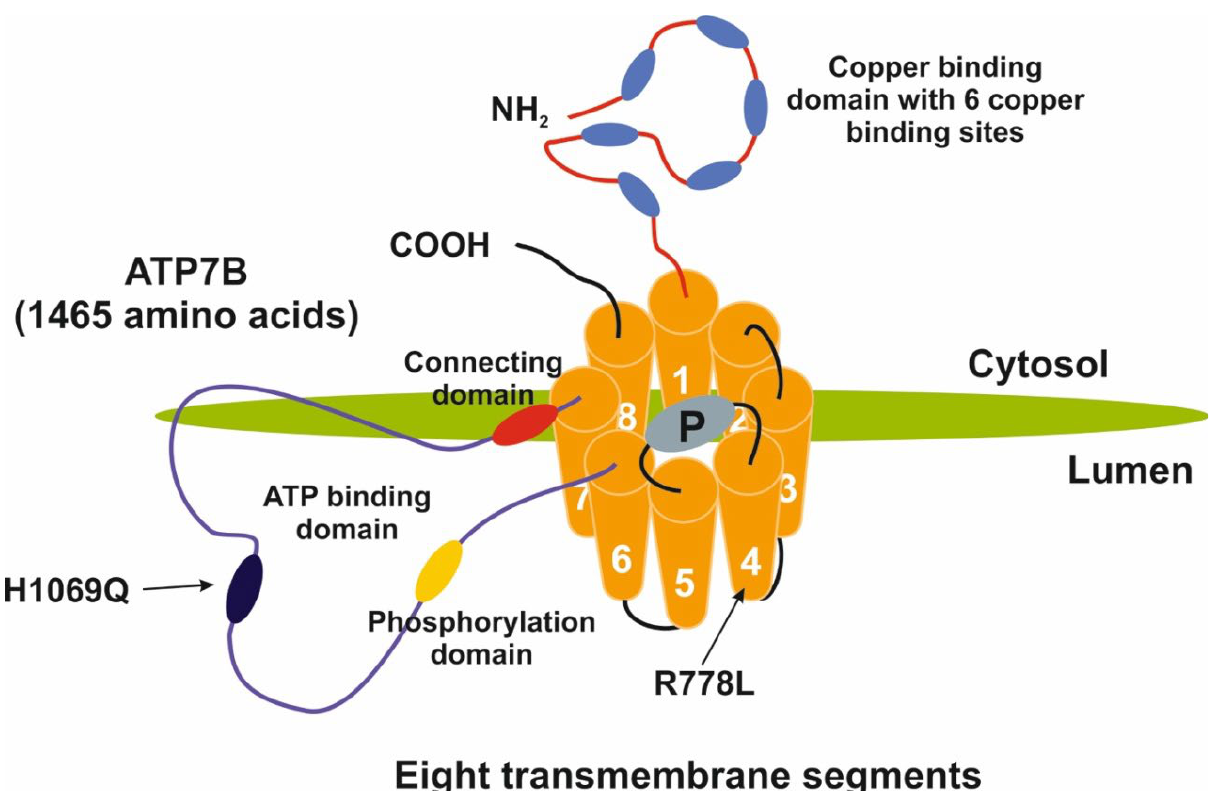
Figure 2. Schematic structure of the ATP7B copper transporter. The N-terminal domain of ATP7B contains 6 copper binding domains, and the eight transmembrane domains constitute a pore structure allowing copper to be transported through the membrane of the trans-Golgi network. The ATP-binding domain is located on the luminal side. The two most frequent mutations (p.H1069Q (US and Europe) and p.R778L (Asia) are indicated. A copper transport mechanism based on cryo- electron microscopy of Xenopus tropicalis ATP7B (highly homologous to human ATP7B) was recently published [26].